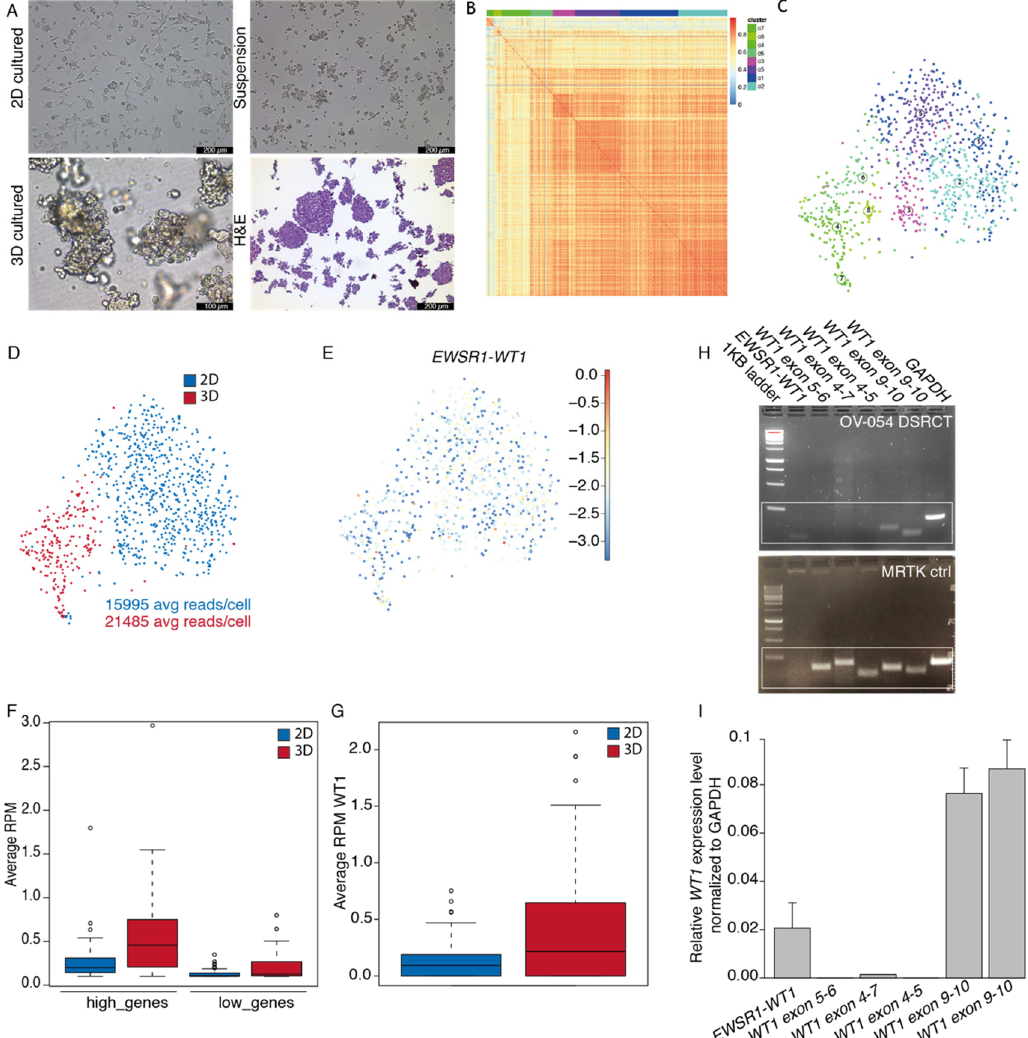
Figure 1. Establishment of a patient-derived DSRCT model in vitro. ( A ) Pictures of OV-054 DSRCT cells in different growth conditions: 2D on 0.1% BME, 3D in BME droplets and in suspension without BME. H&E staining is performed on cells in suspension. Scale bar: 100 µm (3D) and 200 µm (2D, suspension, and H&E). ( B ) Heatmap depicting cell clustering, based on differentially expressed genes. ( C ) tSNE plot depicting clusters of OV-054 DSRCT cells. ( D ) tSNE plot depicting clustering of 2D (blue) and 3D (red) cultured OV-054 DSRCT cells. ( E ) tSNE plot depicting EWSR1-WT1 expression in 2D and 3D OV-054 DSRCT cells. ( F ) Box plot depicting the average RPM in 2D (blue) and 3D (red) cultured DSCRT cells for highly expressed and lowly expressed gene sets. ( G ) Box plot depicting the average WT1 RPM in 2D (blue) and 3D (red) cultured OV-054 DSRCT cells. ( H ) Picture depicting gel electrophoresis of PCR amplicons of the EWSR1-WT1 fusion breakpoint and different regions of WT1 from cDNA of OV-054 DSRCT cells and MRTK control cells. ( I ) Bar plot depicting relative expression of EWSR1-WT1 and different regions of WT1 by qPCR, normalized to GAPDH .